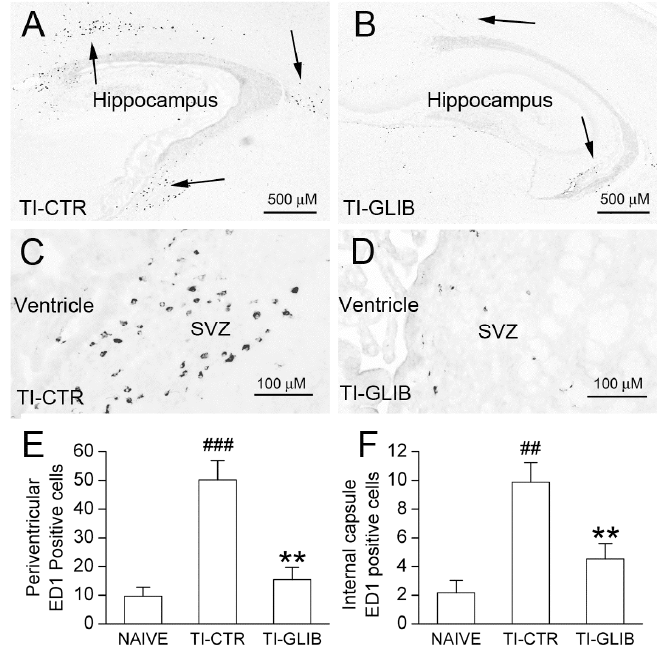
Figure 6. Prenatal low dose glibenclamide infusion reduces the number of ED-1 positive cells following tandem insults. ( A – D ) low power views of the hippocampus ( A , B ) and high power views of the subventricular zone (SVZ) ( C , D ) immunolabeled for ED-1 in pups subjected to TI whose mother was administered no treatment or vehicle treatment (TI-CTR) ( A , C ), or in pups subjected to TI whose mother was administered low dose glibenclamide infusion after IUI (TI-GLIB) ( B , D ); arrows in ( A ) and ( B ) point to groups of ED-1-positive cells. ( E , F ) counts of ED-1 positive cells in periventricular regions ( E ) and in the internal capsule ( F ) in 3 groups of rats, as indicated; ## and ### , p < 0.01 and p < 0.001, respectively, comparing naïve and TI-CTR; ** p < 0.01 comparing TI-CTR and